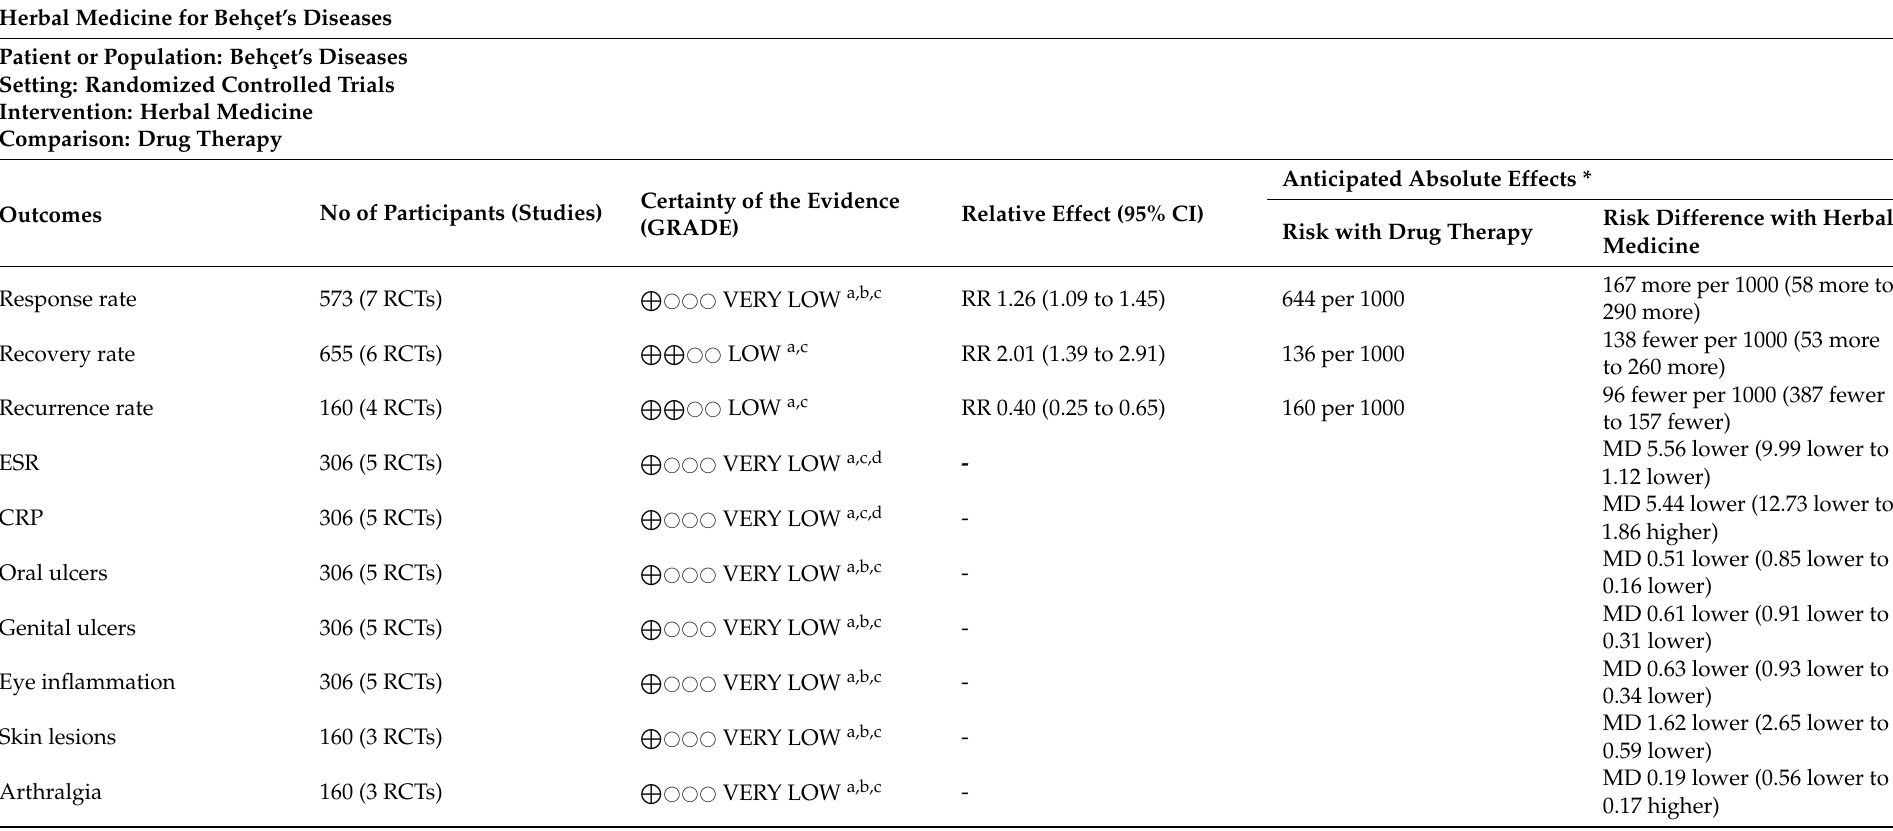
Table 3. Summary of